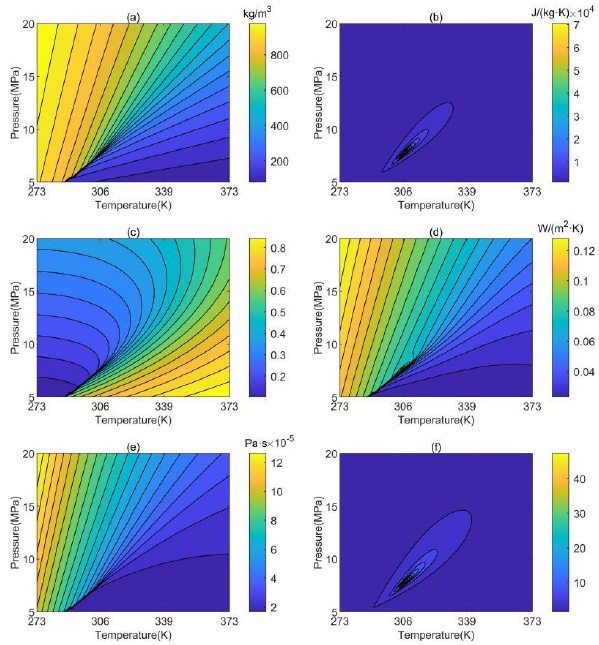
Figure 7. Thermophysical properties of methane at temperatures ranging from 273 to 373 K and pressures ranging from 5 to 20 MPa: ( a ) density, kg/m 3 ; ( b ) isobaric heat capacity, J/(kg·K); ( c ) compressibility factor (Z); ( d ) thermal conductivity, W/(m·K); ( e ) viscosity, Pa·s; ( f ) specific heat capacity, J/(kg·K).